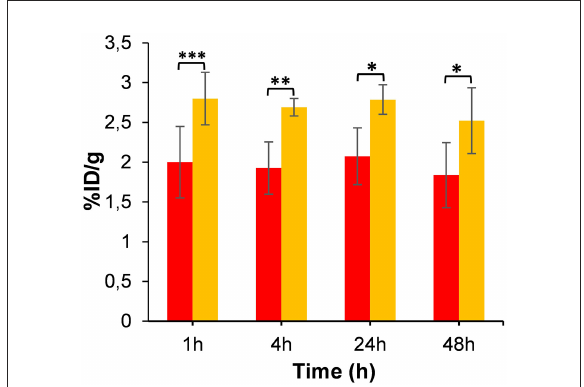
FIGURE7 Tumor uptake of [ 64 Cu]NOTA-C3-TP (%ID/g) derived from static PET images at 4, 24, and 48h post-injection relative to that of 1-h dynamic scan ( n = 4). Red and yellow bars represent tumor uptake without and with co-injection of [ Nat Cu]NOTA-C3-TP (100-fold excess), respectively (* p value < 0.05, ** p value < 0.01, *** p value <